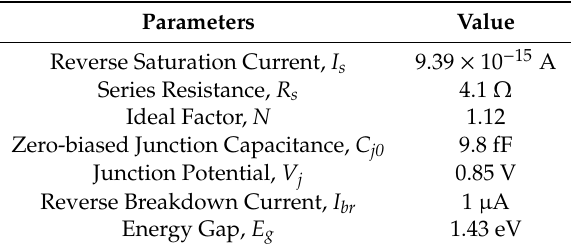
Table 2. Some key SPICE parameters of the diodes. Table 1. Layer Structure Parameters of the diodes used in this paper.